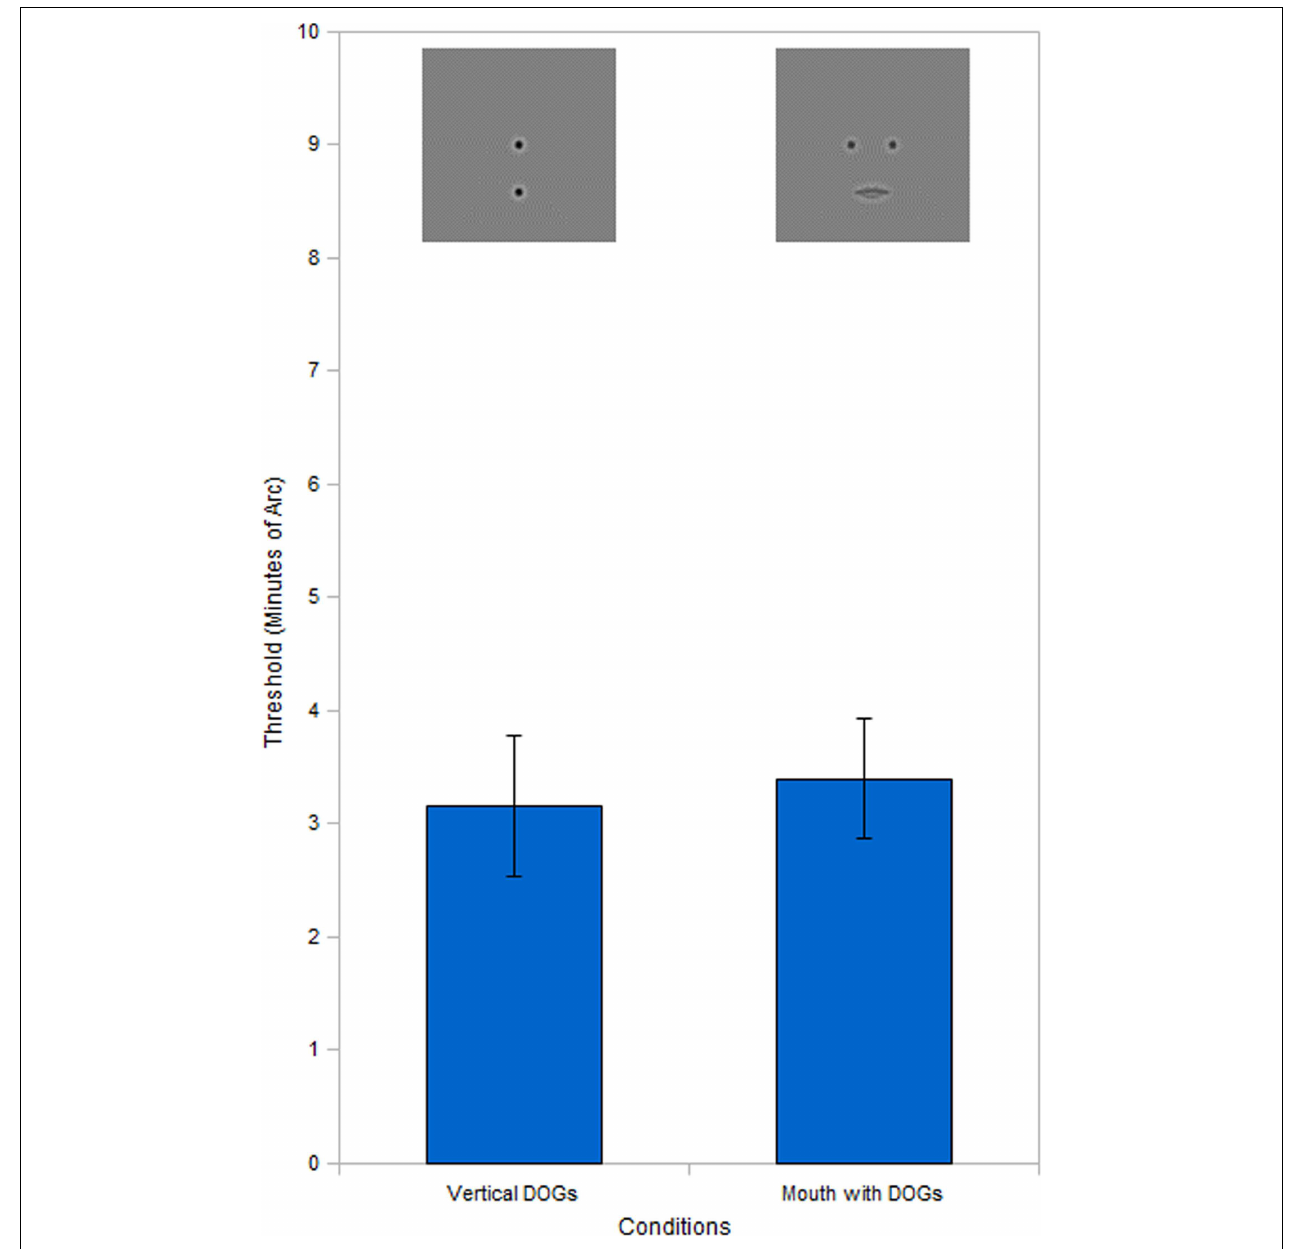
FIGURE 6 |Vernier acuity comparison. Results show no significant difference between the mouth with DOGs condition and the vertical DOGs.Threshold data for vertical DOGs condition obtained by using probability summation on the raw threshold data. Error bars represent standard error.